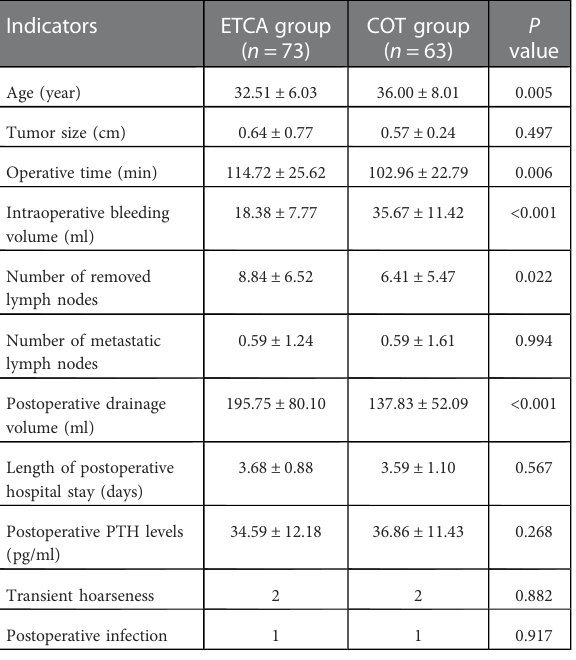
TABLE 1 Comparison of indicators between the two groups.